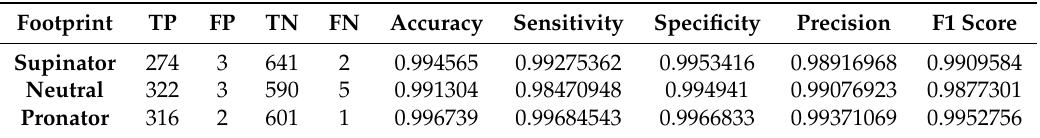
Table 3. Classification results with the testing dataset.